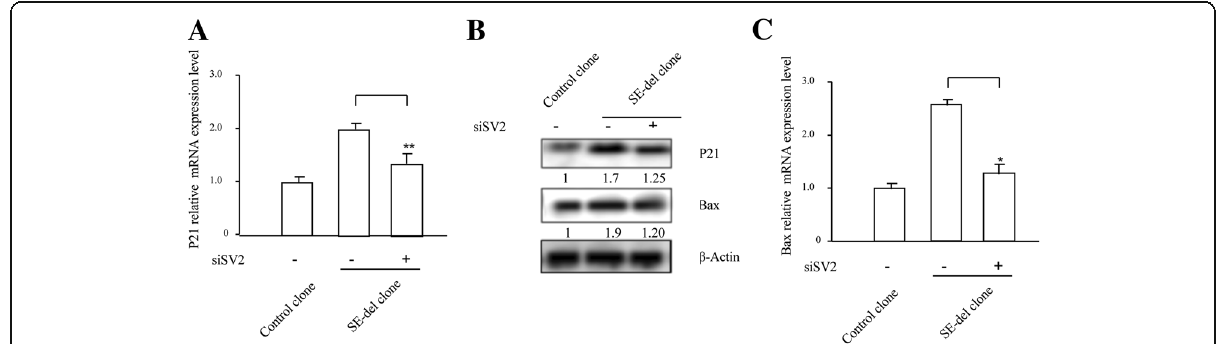
Fig. 4 Over-expression of Klf6-SV2 triggers increased expression of p21 and Bax . a Expression of p21 mRNA in SE-del clone transfected with siSV2. The results represent the mean of three amplifications, ** p < 0.01. b Expression of p21 and Bax proteins in SE-del clone transfected with siSV2. The gels are representative of three analyses. c Expression of Bax mRNA in SE-del clone transfected with siSV2. The results represent the mean of three amplifications, * p < 0.05